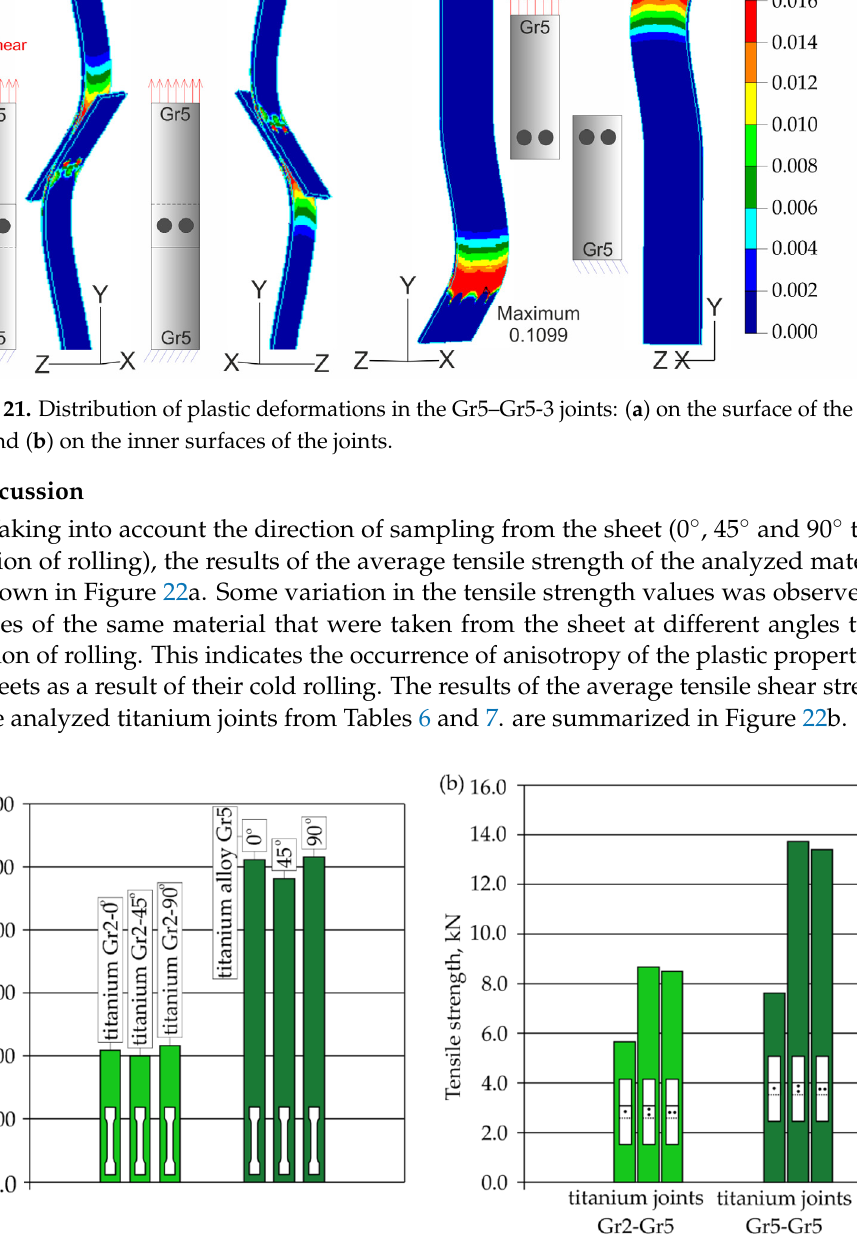
Figure 22. Summary of results: ( a ) the average tensile strength of the analyzed materials depending on the angle at which the sample was taken from the sheet and ( b ) average tensile shear resistance of analyzed RSW joints.